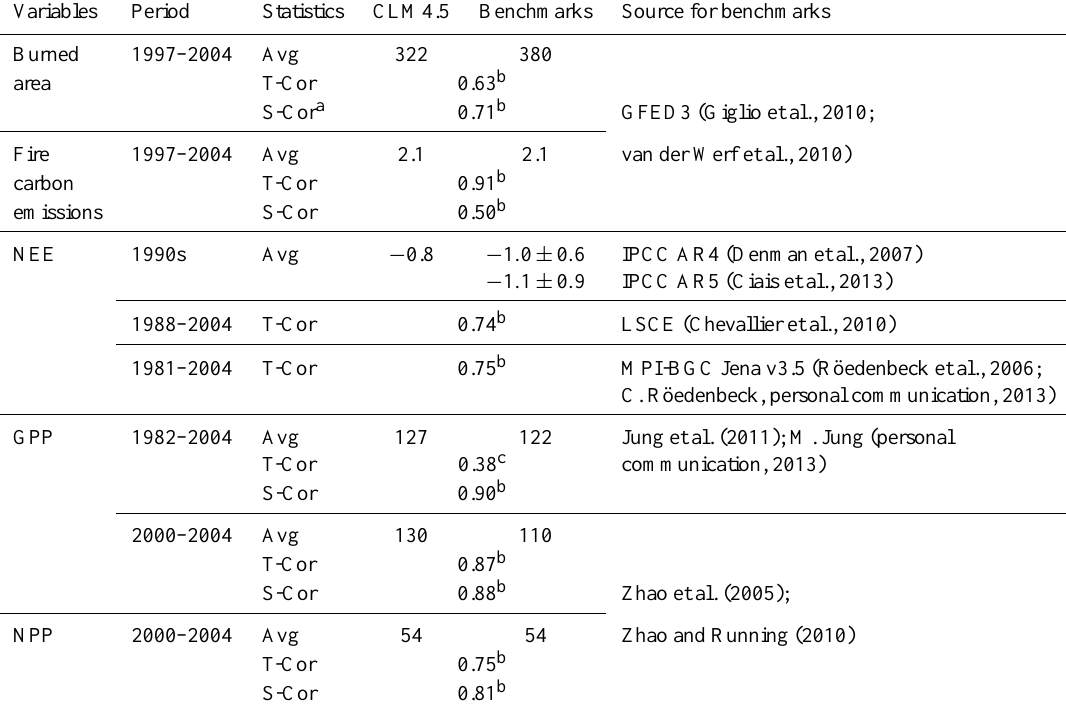
Table 1. Comparison between CLM4.5 simulations and benchmarks for burned area, fire carbon emissions, net ecosystem exchange (NEE, a negative value indicates a land uptake of carbon), gross primary production (GPP), and net primary production (NPP). Statistics include the average (Avg), temporal correlation of annual global total between CLM4.5 and benchmarks (T-Cor), and global spatial correlation of multi-year average between CLM4.5 and benchmarks with a spatial resolution of 1.9 ◦ (lat) × 2.5 ◦ (lon) (S-Cor) during the common periods of simulations and benchmarks. Units of Avg are Mhayr − 1 for burned areas and Pg Cyr − 1 for fire carbon emissions, NEE, GPP and NPP, where Pg = 10 15